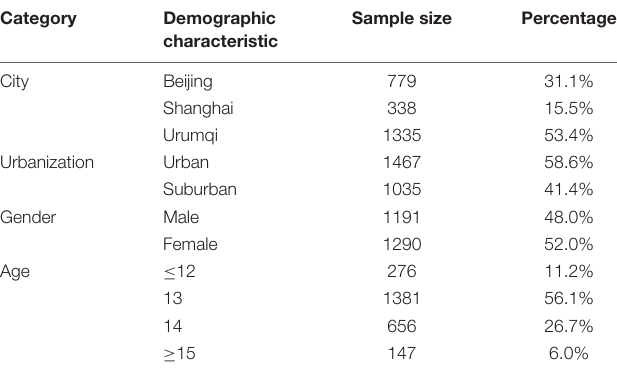
TABLE 1 | Descriptive statistics of